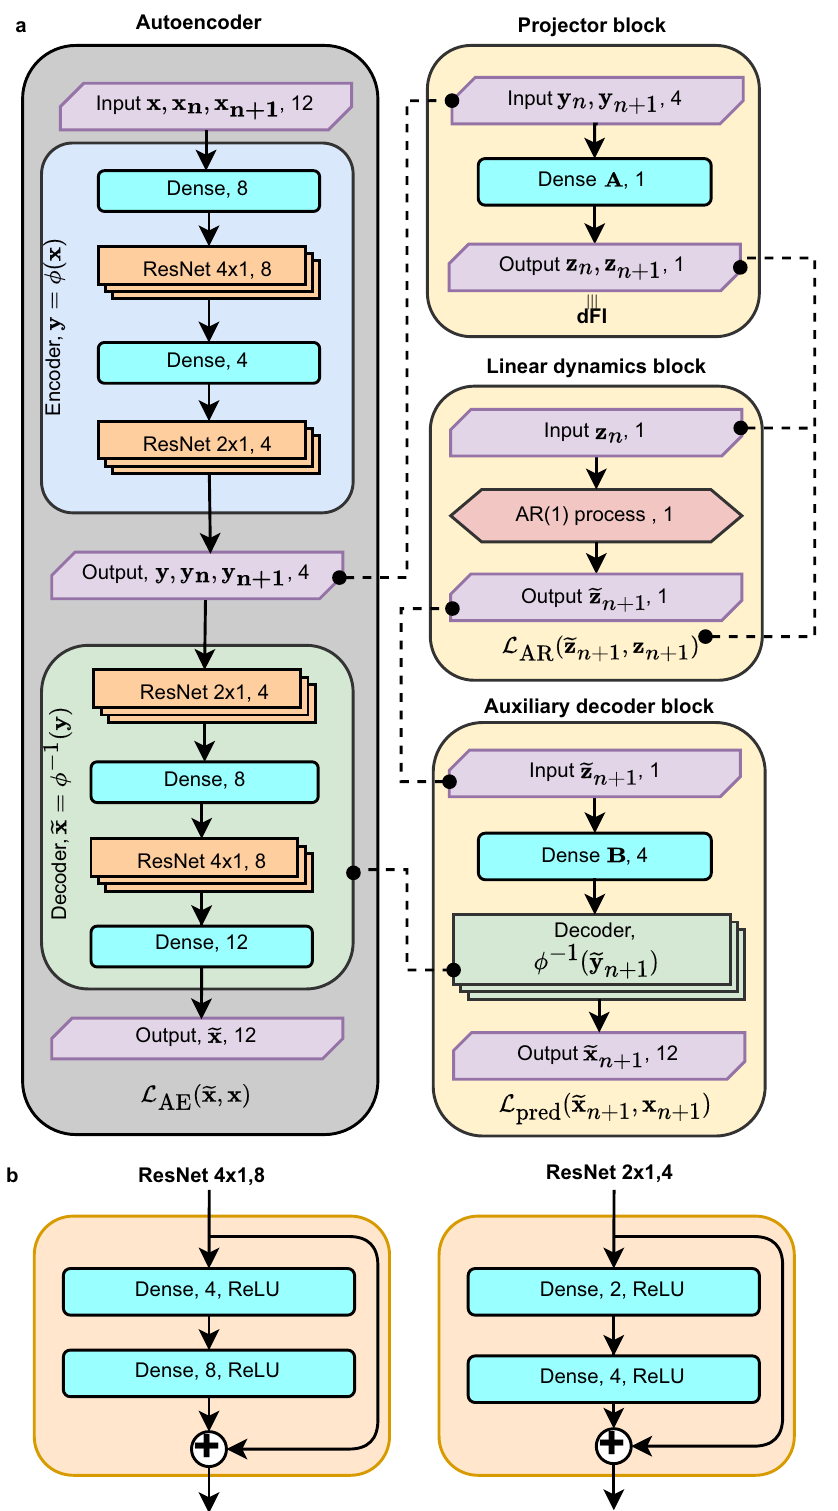
Fig.7|Theschematicrepresentationofthenetworkarchitectureusedtotrain dFI.a Thenetworkincludesofnonlinearauto-encoder(AE)andtheauto-regression model (AR), the linear projector, and the decoder blocks. The output of the